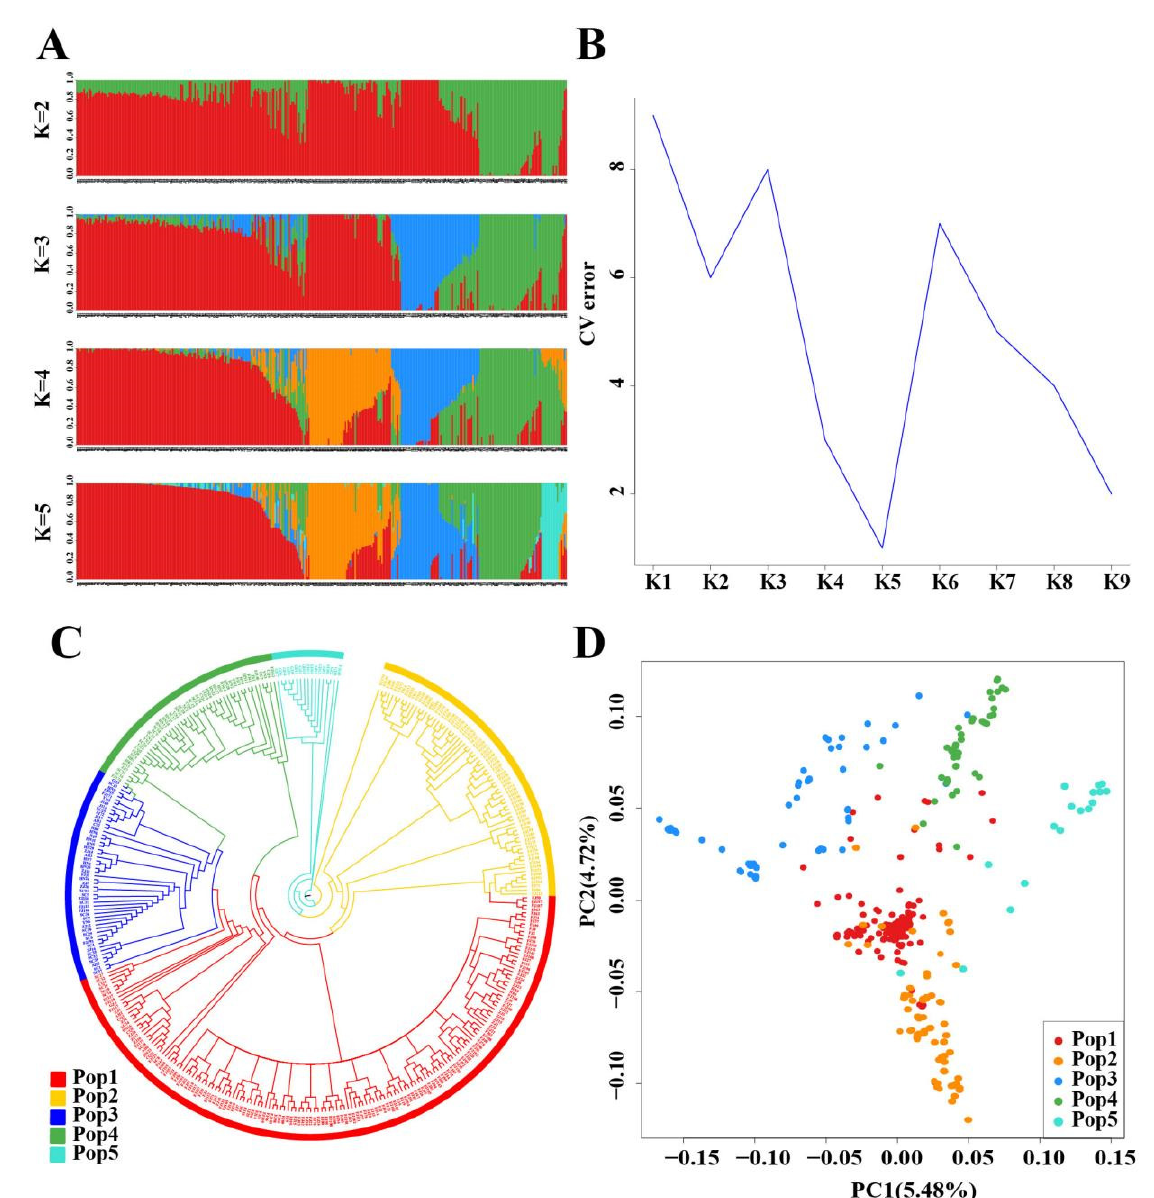
Figure 1. Population structure, unrooted neighbor-joining tree and principal component analysis of 349 tea trees based on the 12,937,679 perfect SNPs. ( A ) Population structure of the tea trees, with different K-values, based on Model-based clustering; ( B ) Cross-validation error (CV error); ( C ) Unrooted neighbor-joining tree of 349 samples; ( D ) Principal component analyses (PCA) of all popula- tions.